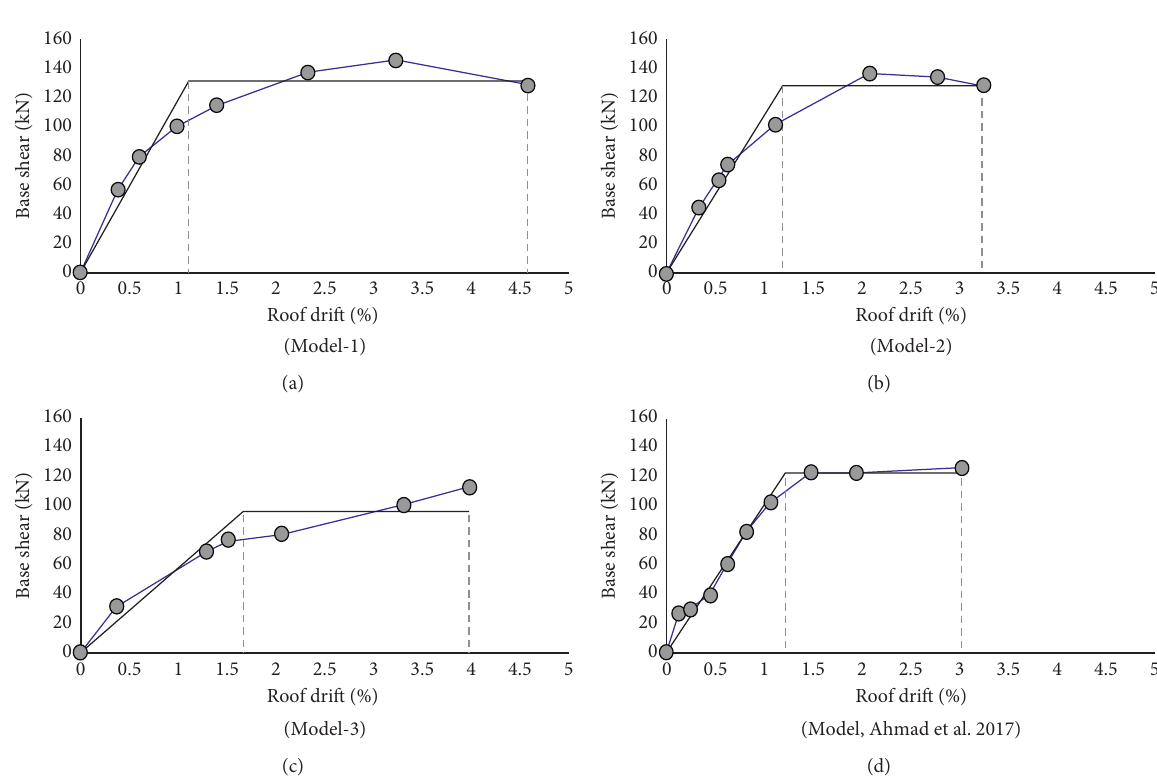
Figure 8: Test data set force-deformation relationship bilinear idealizations.